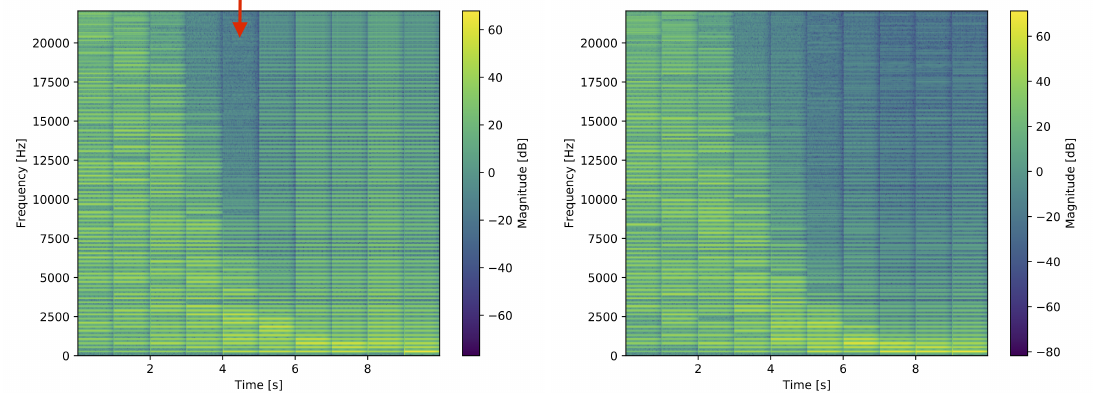
Figure 4. Spectrograms of GP wavetable synthesis with a squared exponential kernel. The length-scale is increased 10 times. ( left ) Without GP regression, there is usually more energy in the higher harmonics at smaller length-scales. If, by chance, the wavetable is continuous at its boundary, then there is a distinct change in the spectrum with a reduction of energy at the higher harmonics (marked with an arrow). ( right ) With GP regression, the energy in the harmonics decreases more predictably with increasing